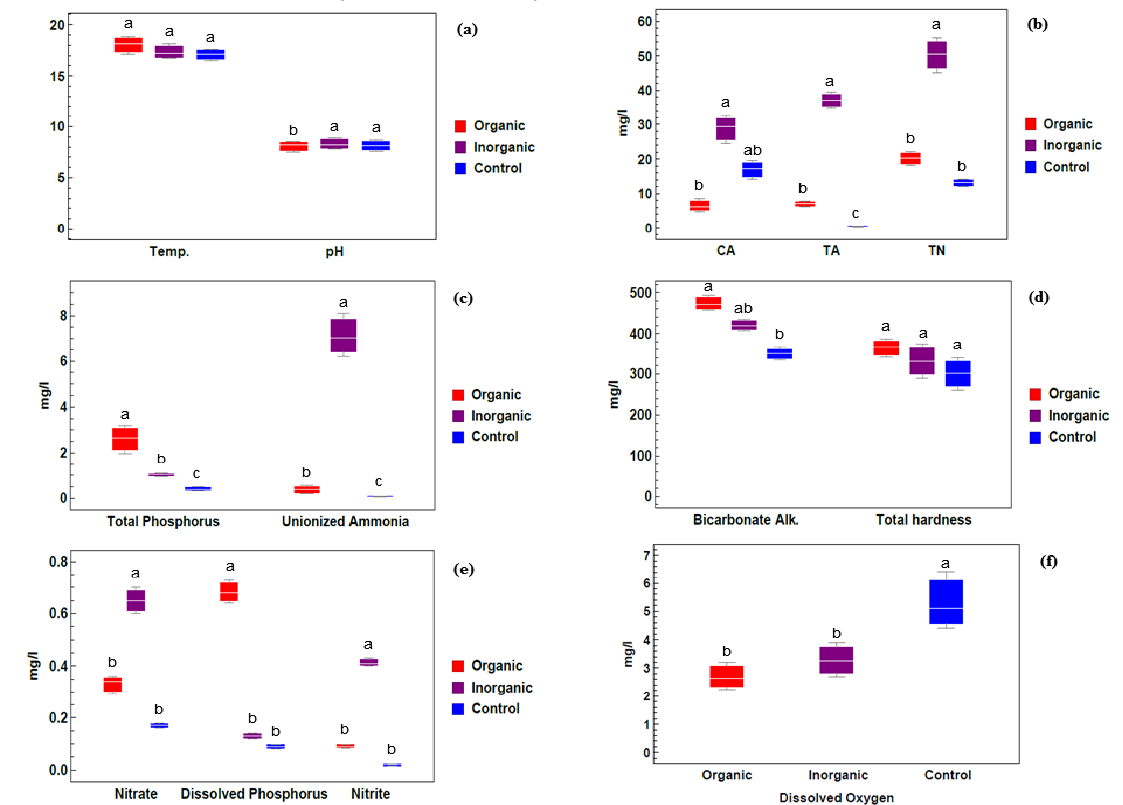
Figure 1. Physico-chemical parameters of water samples collected from different treatment groups: organic, inorganic and control. ( a ) Temperature, Hydrogen ion concentration; ( b ) CA (Carbonate Alkalinity), TA (Total Ammonia), TN (Total Nitrogen); ( c ) Total Phosphorus, Unionized Ammonia; ( d ) Bicarbonate alkalinity, Total hardness; ( e ) Nitrate, Dissolved Phosphorus, Nitrite; ( f ) Dissolved Oxygen. Different lowercase letters indicate significant differences between different treatments at p ≤ 0.05 .